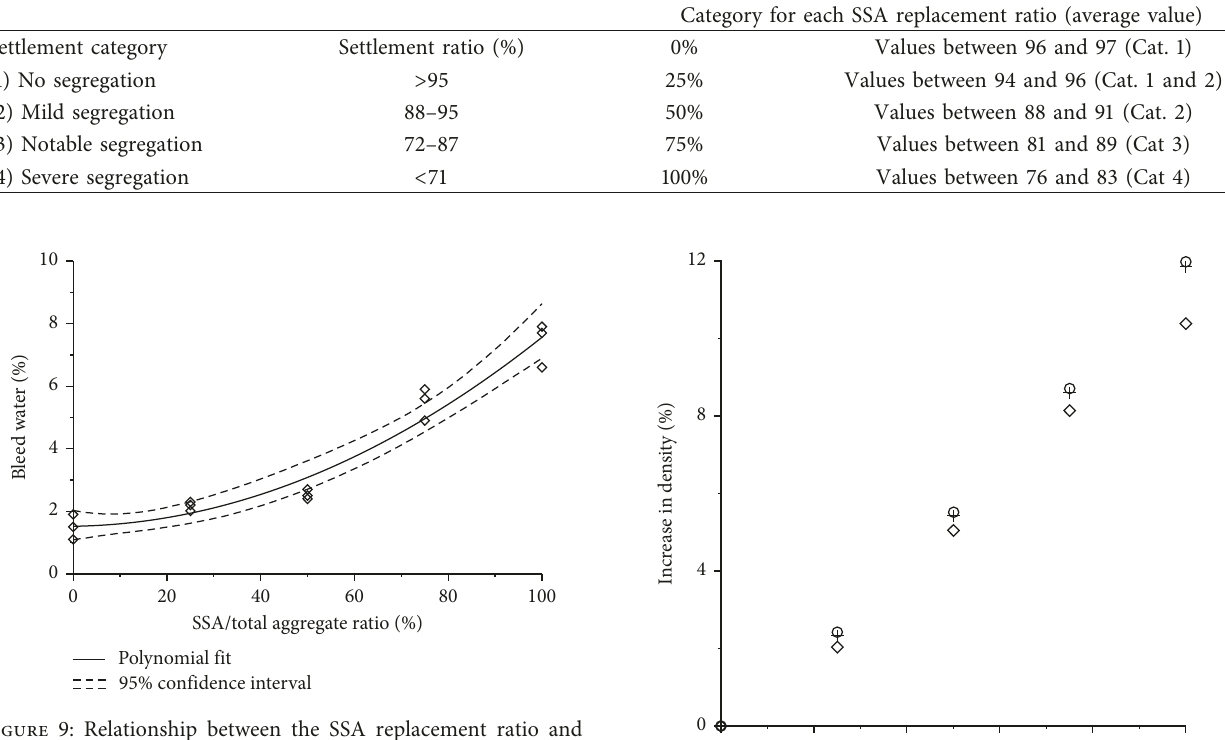
Figure 9: Relationship between the SSA replacement ratio and amount of bleed water.